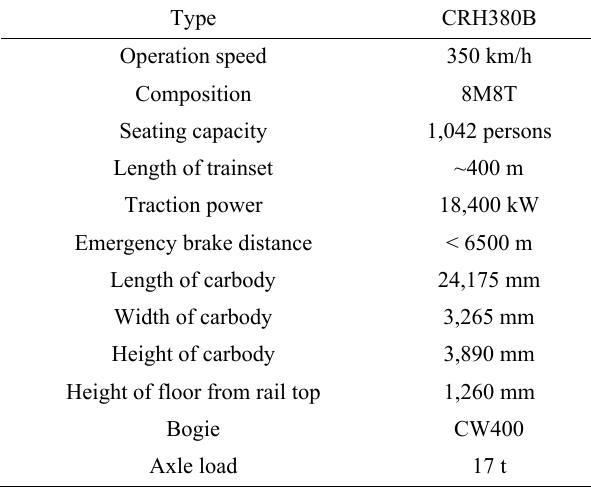
Table 2 CRH380B high-speed train parameters